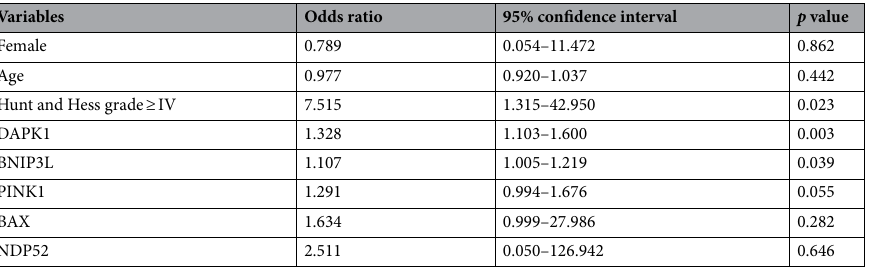
Table 2. Multivariable logistic regression analysis for the development of delayed cerebral ischemia following subarachnoid hemorrhage. BAX Bcl-1 antagonist X, BNIP3L BCL2 interacting protein 3 like, DAPK-1 death- associated protein kinase-1, NDP52 nuclear dot protein 52, PINK1 PTEN-induced kinase